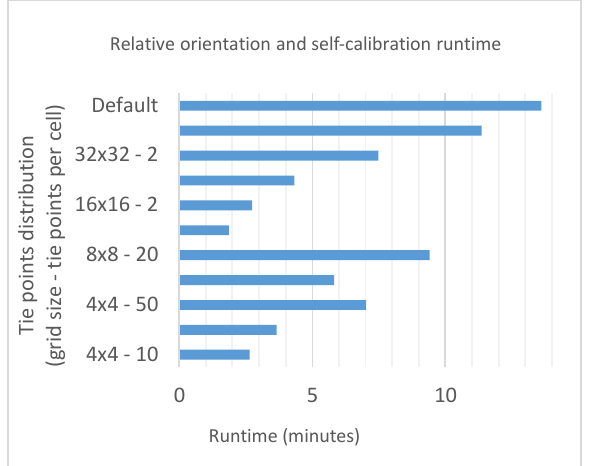
Figure 6. Relative orientation and self-calibration runtime. Example with a dataset of 124 aerial images (6000x4000 pixels).